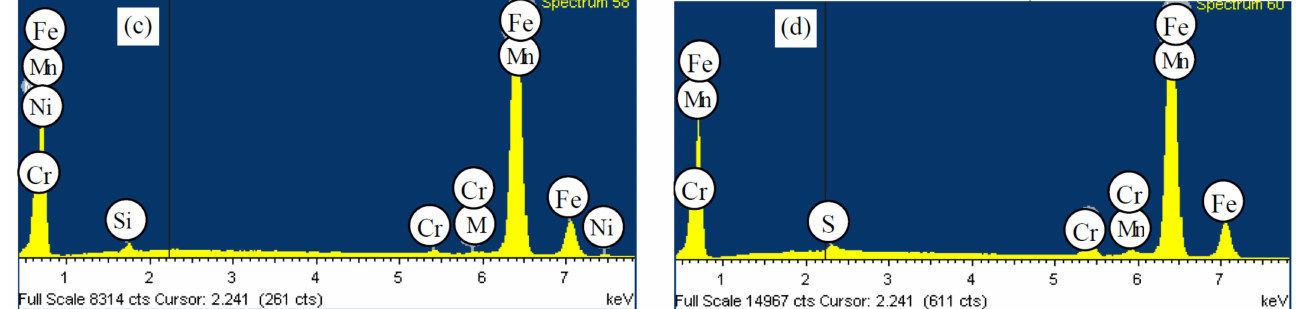
Figure 5. The components’ distribution according to the structural components of the hypereutectoid steel with 1.8% C after double normalizing. ( a )—cementite, which is a part of the carbide mesh; ( b )—depleted area next to the cementite mesh; ( c )—perlite; ( d )—coagulated carbide of Me 3 C